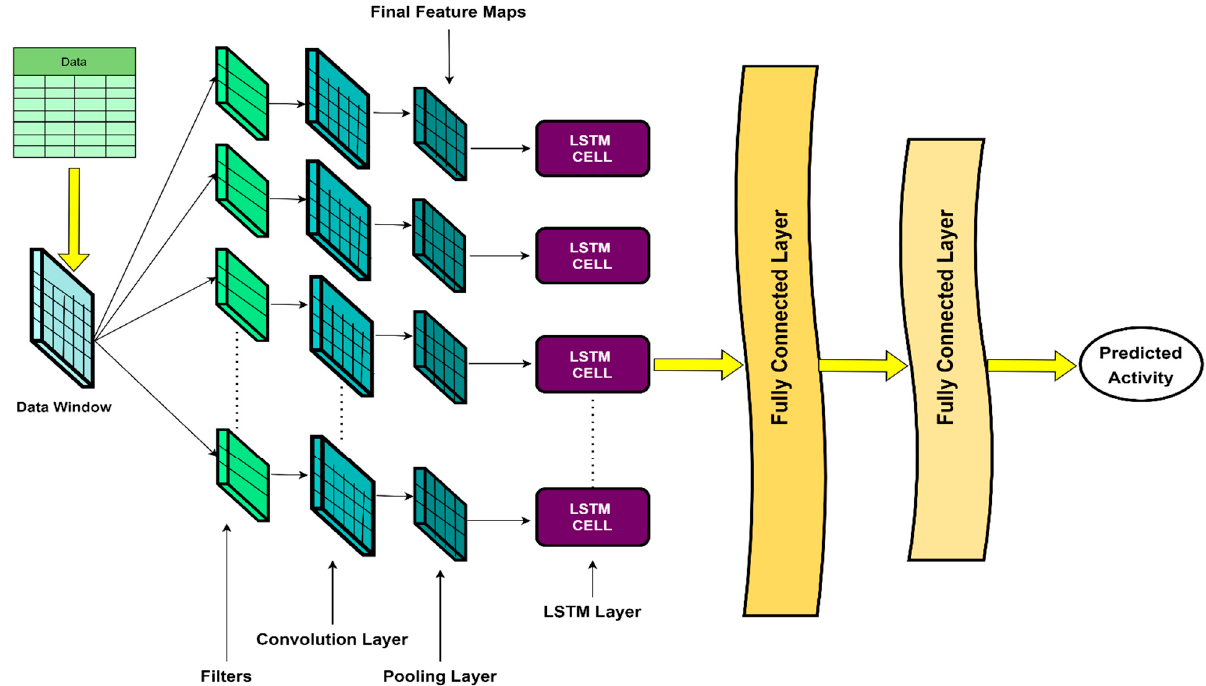
Figure 7. Proposed structure of the 1D-CNN-LSTM